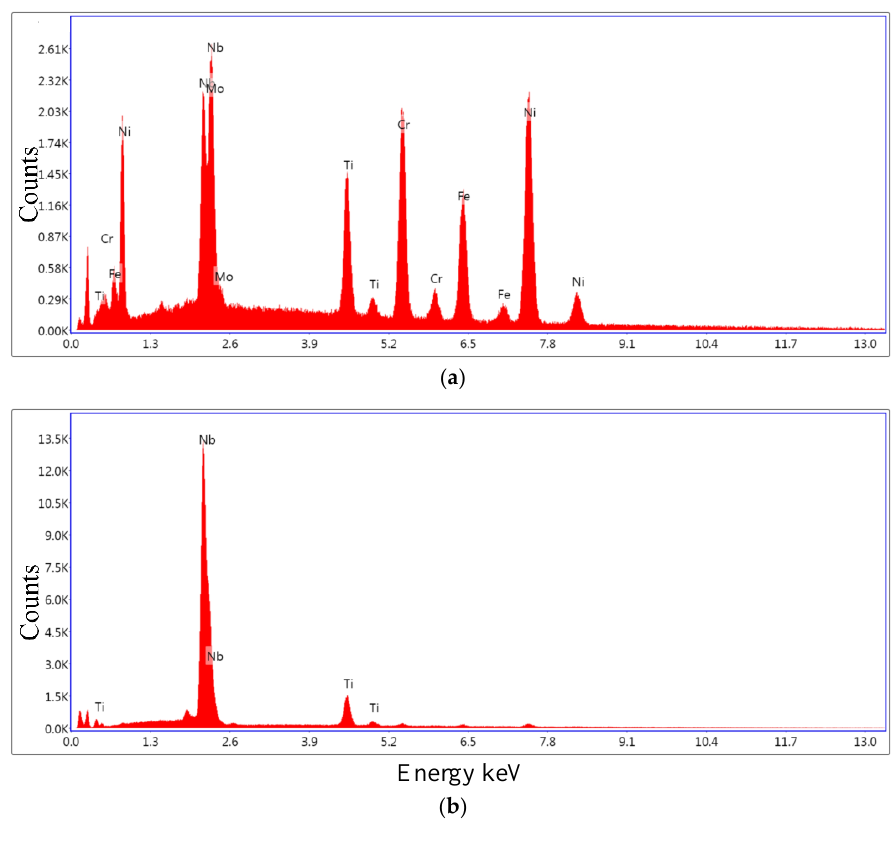
Figure 15. EDS spectra acquired from ( a ) δ-phase and ( b ) MC-type carbide phase.